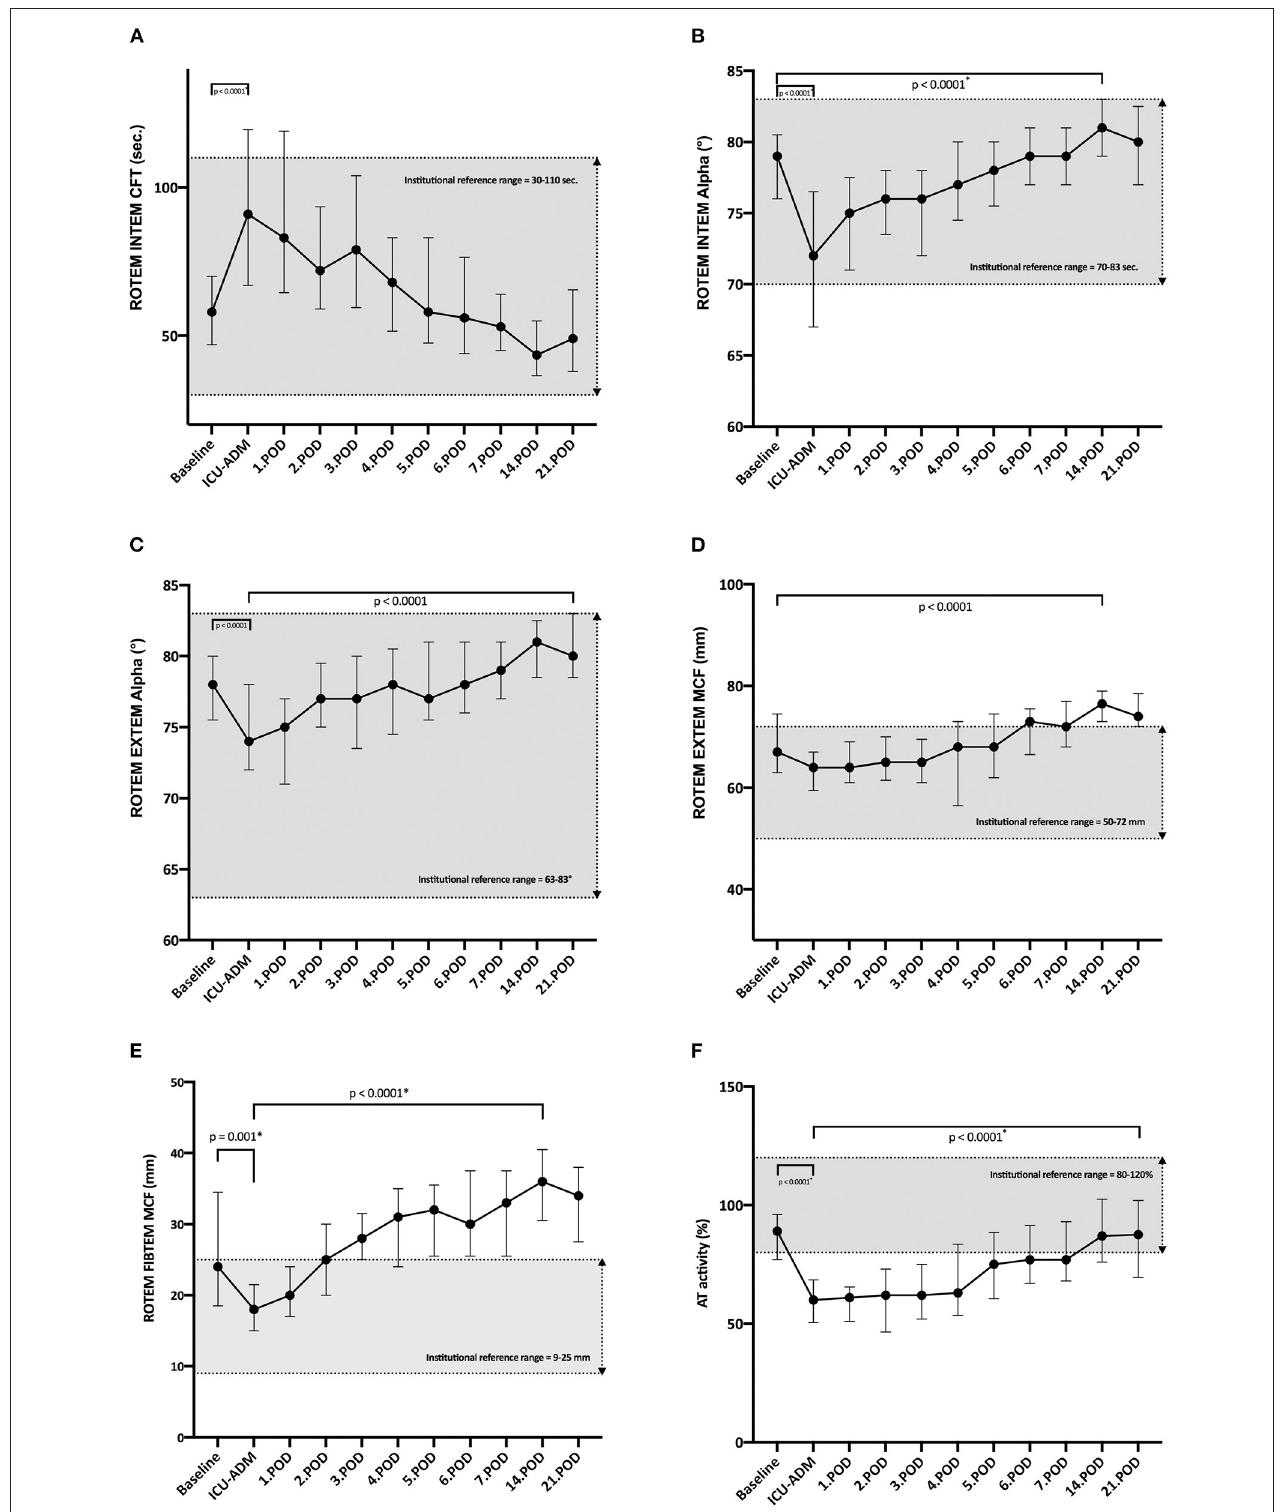
FIGURE 3 | (A) Time course of ROTEM ® INTEM CFT. Whole blood coagulation profiles determined by rotational thromboelastometry (TEM Innovations GmbH; Munich, Germany) with ellagic acid INTEM reagent (TEM Innovations GmbH); sec, seconds; POD, postoperative day; *Non-parametric Wilcoxon test for